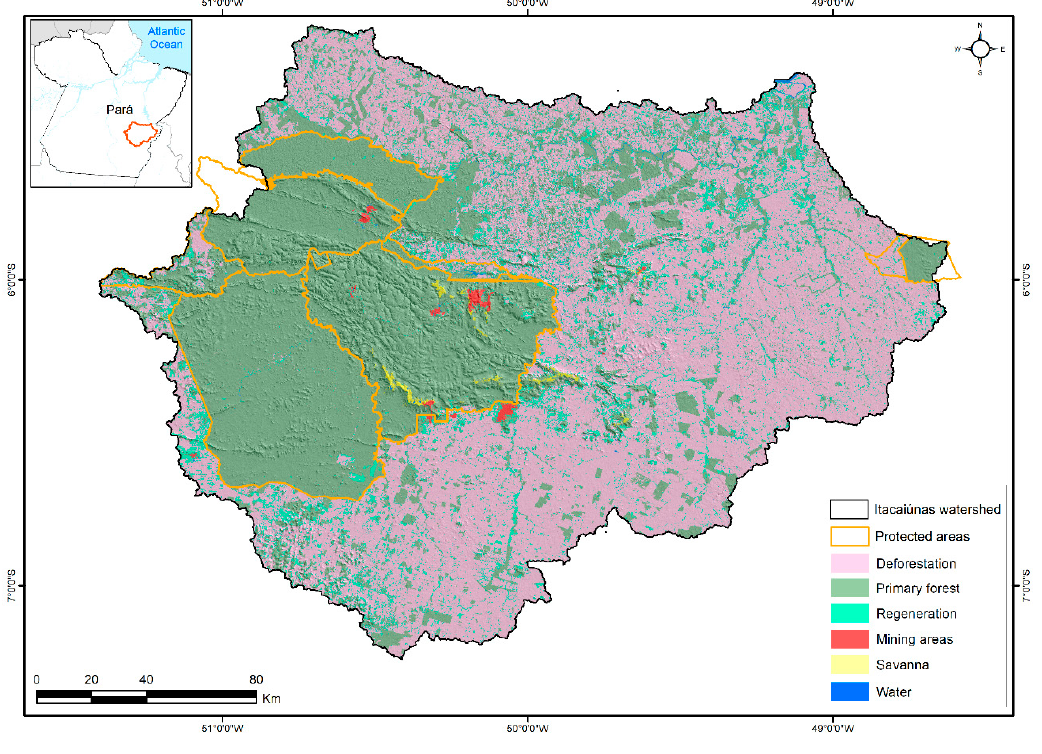
Figure 4. Land cover map of the Itacaiúnas watershed in 2017.